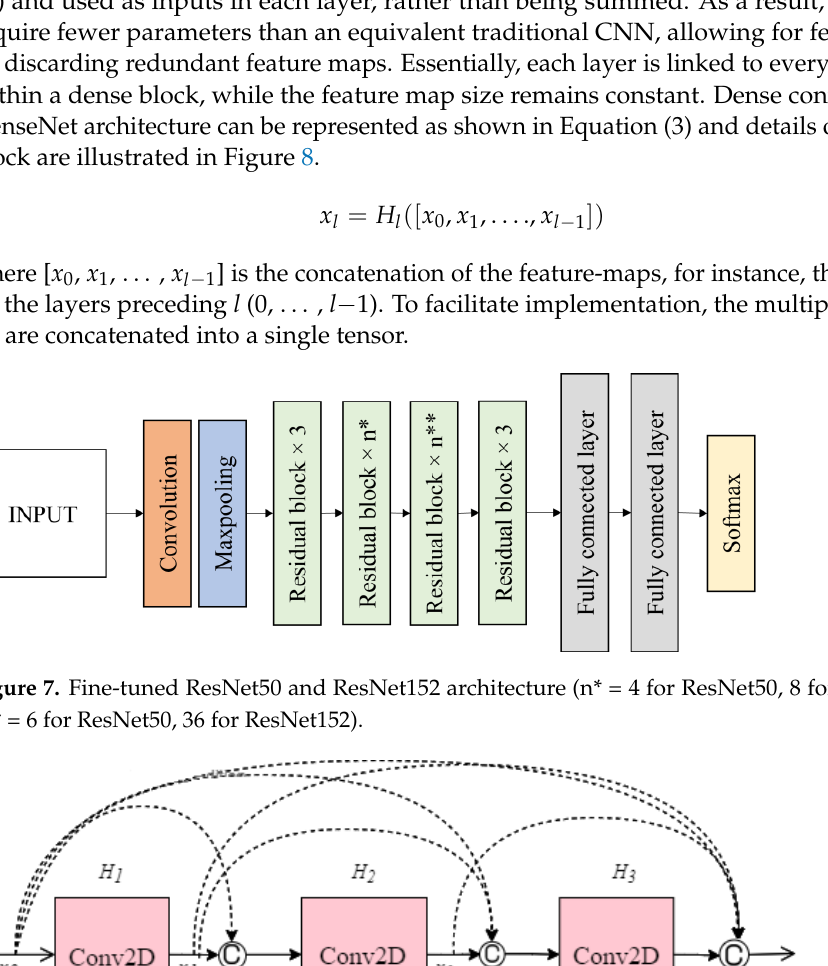
Figure 7. Fine-tuned ResNet50 and ResNet152 architecture (n* = 4 for ResNet50, 8 for ResNet152; n** = 6 for ResNet50, 36 for ResNet152).